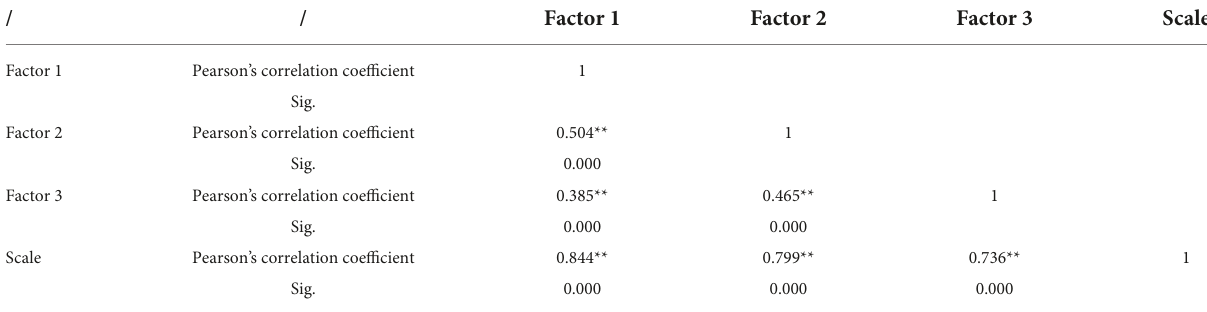
TABLE 5 The correlation among the